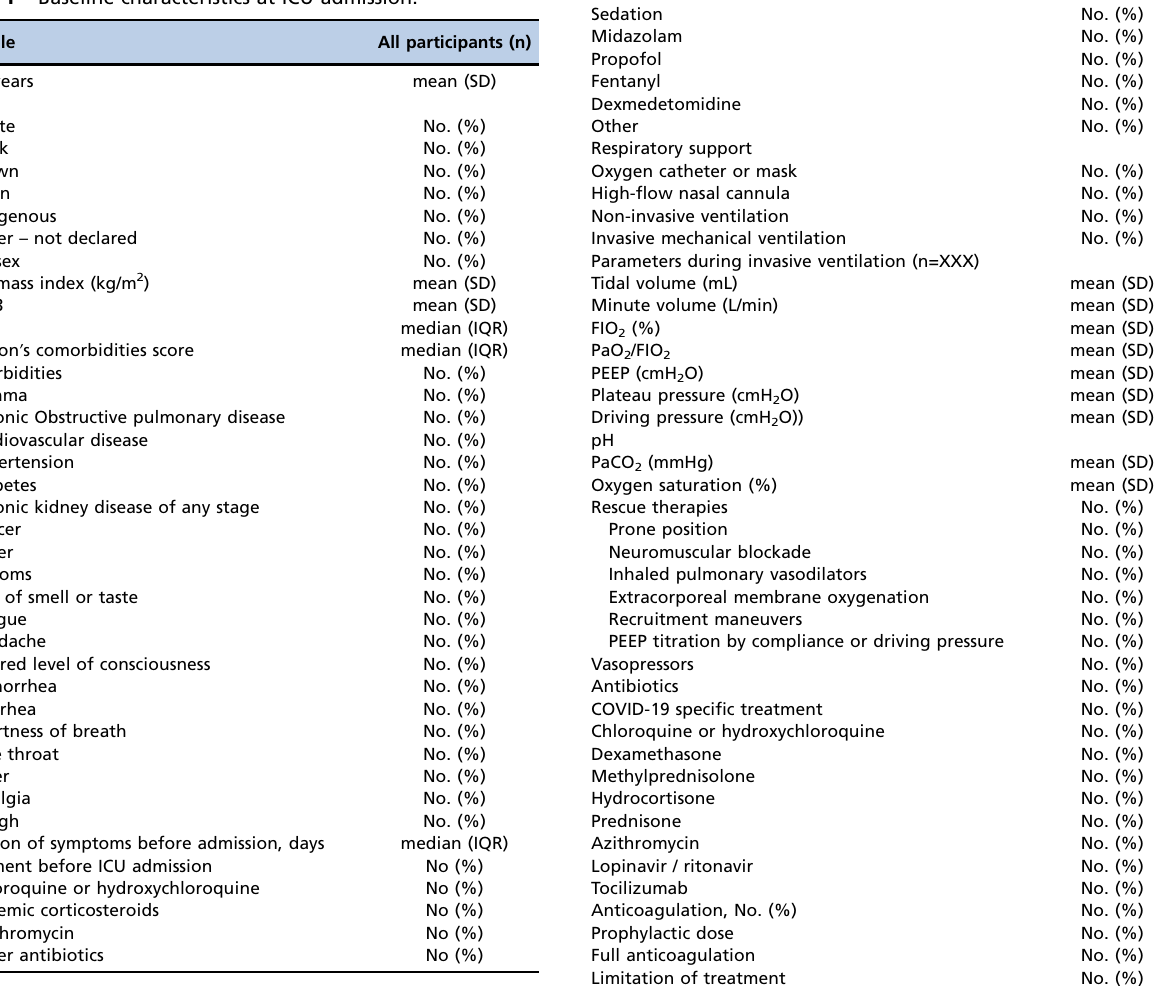
Table 1 - Baseline characteristics at ICU admission.